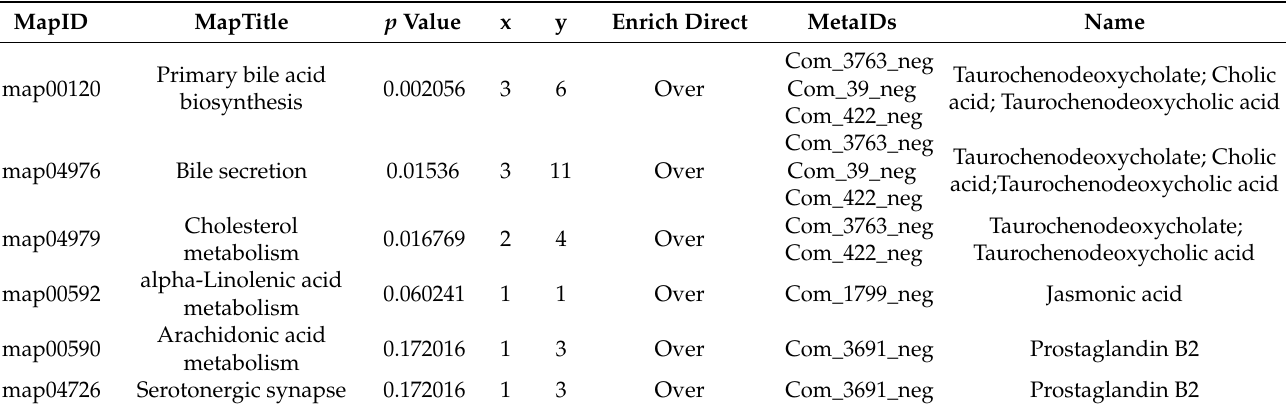
Table 4. KEGG enrichment pathway in negative